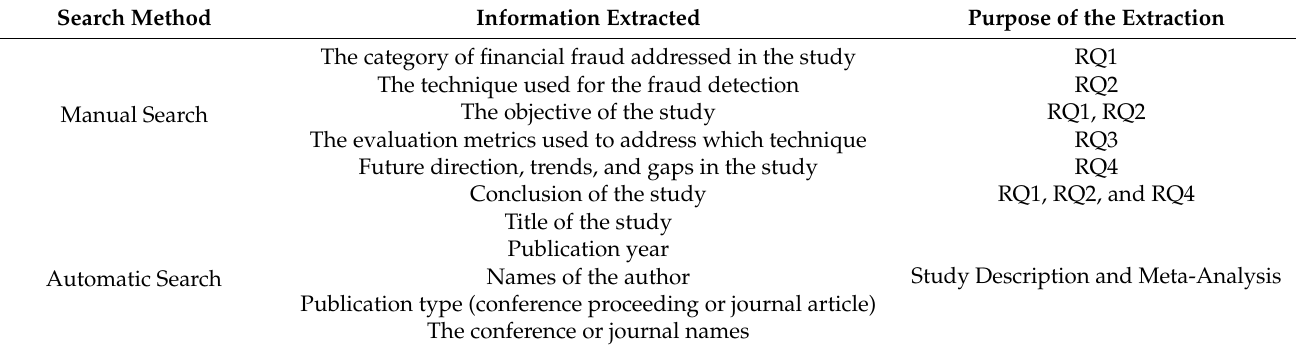
Table 4. Data extraction